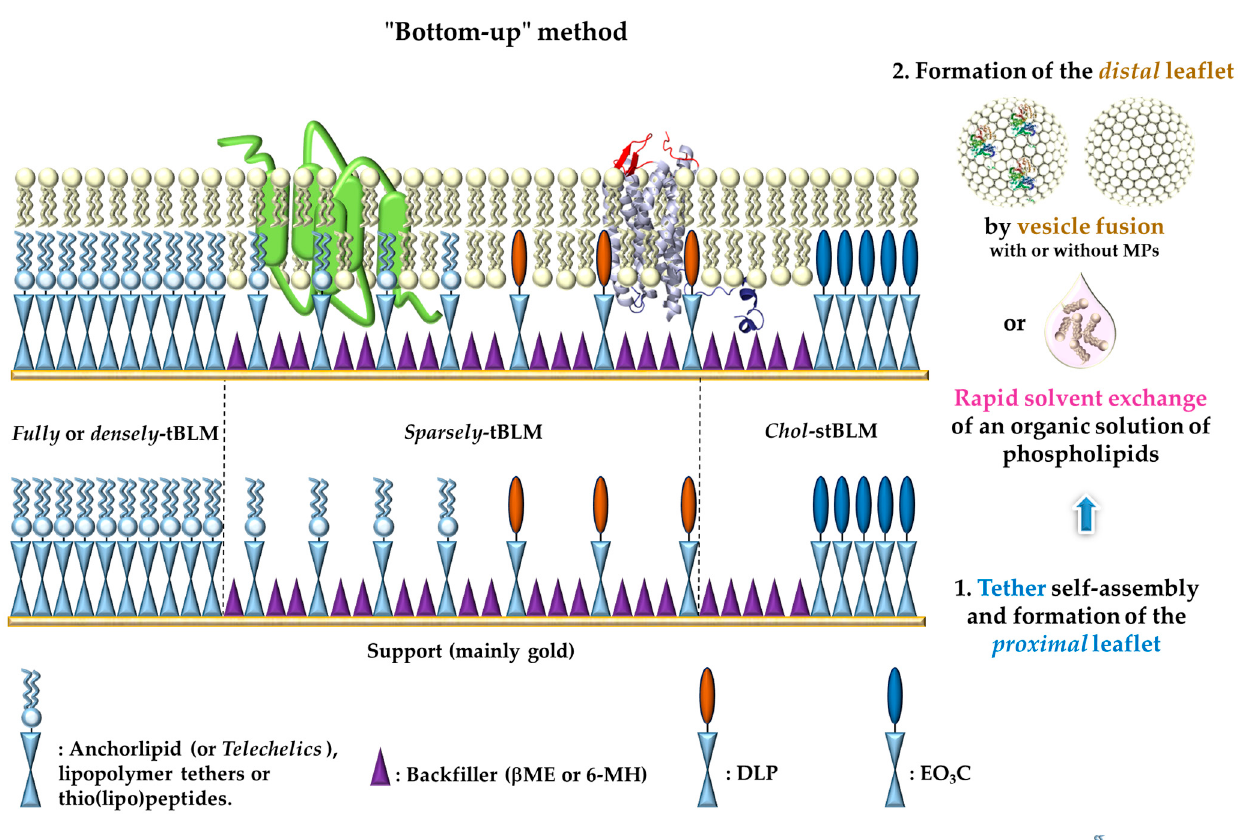
Figure 1. Different types of tethered-Bilayer Lipid Membranes (or tBLMs) obtained by a “bottom-up” approach. : represents either anchorlipid (i.e., Telechelics) mainly 2,3-di- O -phytanyl- sn -glycerol-1-tetraethylene glycol- D , L - α -lipoic acid ester lipid (DPhyTL), lipopolymer tethers or thio(lipo)peptides; : Backfillers, mainly β -mercaptoethaonl ( β ME) or 6-mercaptohexanol (6-MH); : benzyl-disulfide (tetra-ethyleneglycol) n=2 C20-phytanyl tether (or DLP); : ethyleneoxy-linked cholesterol (or EO 3 C).